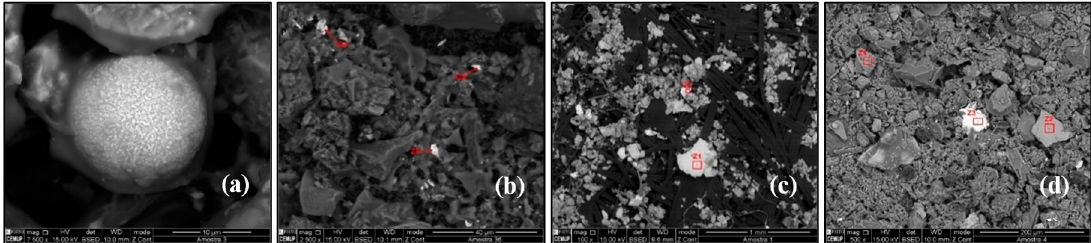
Figure 8. Scanning electron microscopy images of ( a ) aluminosilicates particles, ( b ) biotite particle, ( c ) silicon particles, and ( d ) quartz particles.